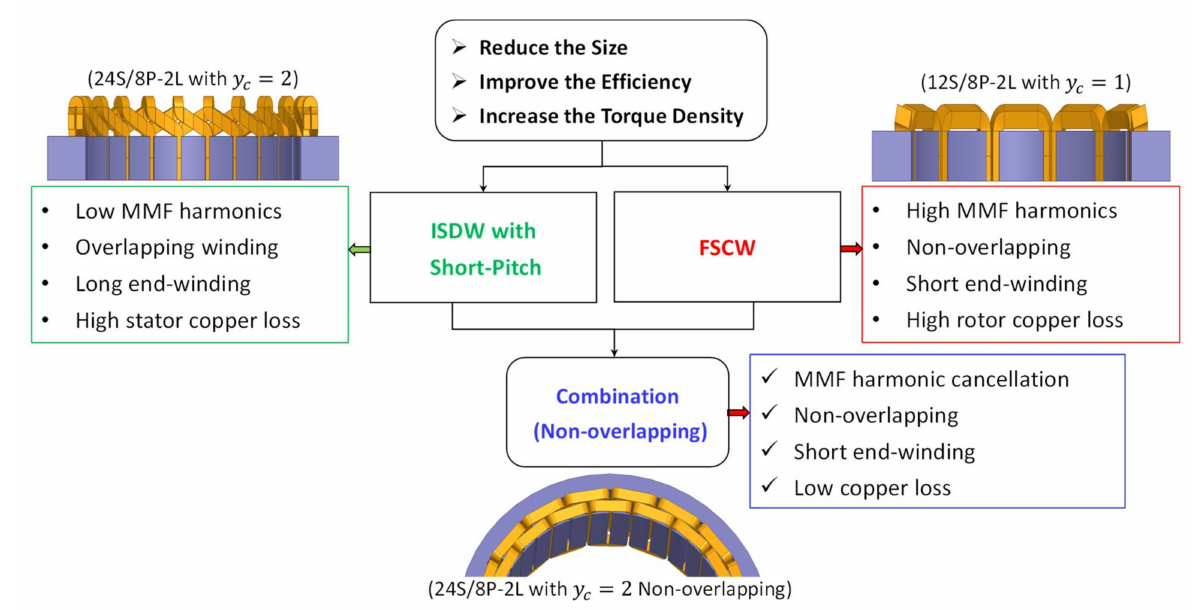
Figure 1. Schematic of the proposed winding improvement method.